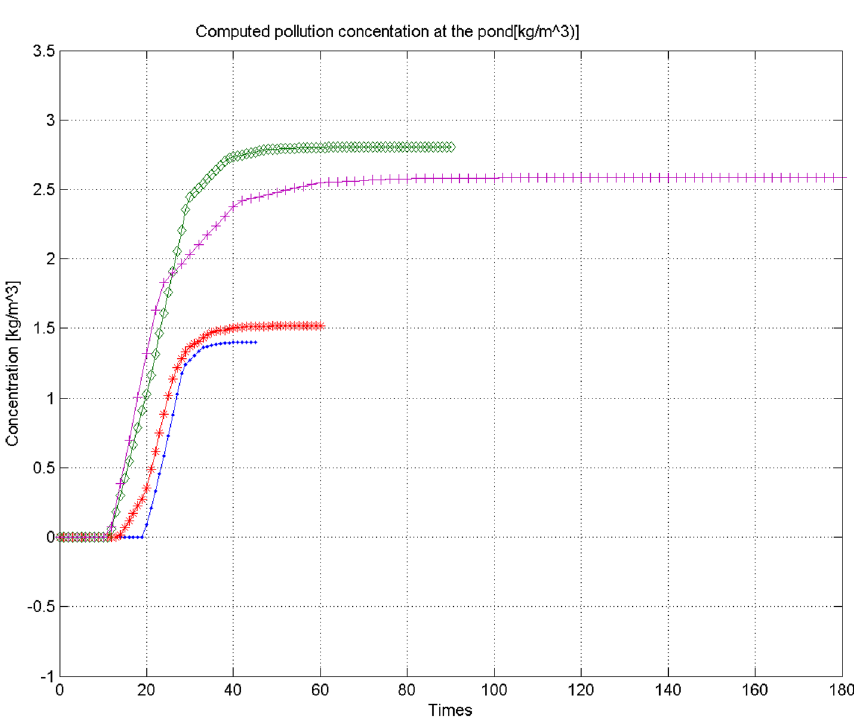
Figure 6. Computed pollution concentration at the pond for different final times ( t f = 45, t f = 60, t f = 90 and t f = 180